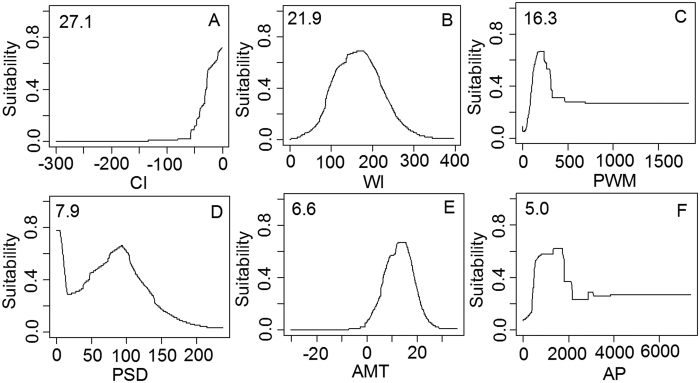
The response curves of climatic suitability for six dominant climatic factors based on MaxEnt model and their relative importance shown in the upper-left corner of each subplot.(A) coldness index (CI, °C); (B) warmth index (WI, °C); (C) precipitation of wettest month (PWM, mm); (D) precipitation of seasonality (PSD, %); (E) annual mean temperature (AMT, °C); (F) annual precipitation (AP, mm).